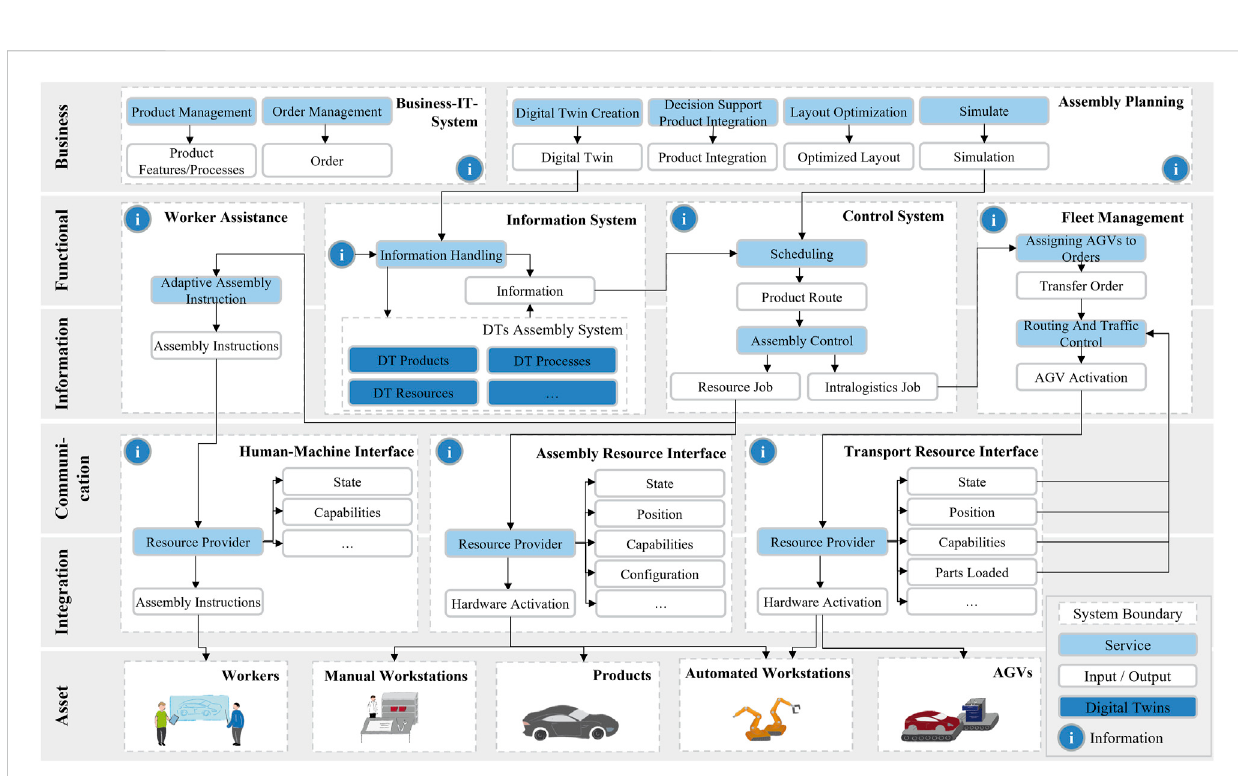
FIGURE 2 Software architecture for planning and controlling line-less assembly systems including digital